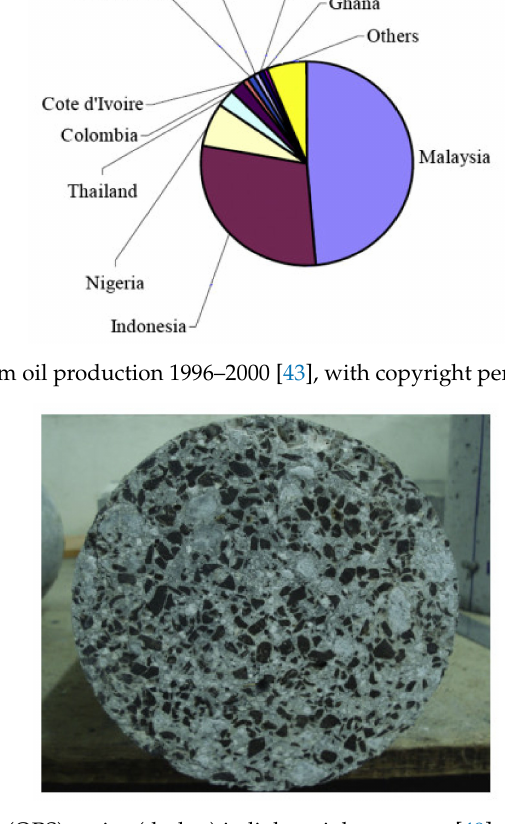
Figure 3. Oil palm shell (OPS) grains (darker) in lightweight concrete [49], with copyright permission from